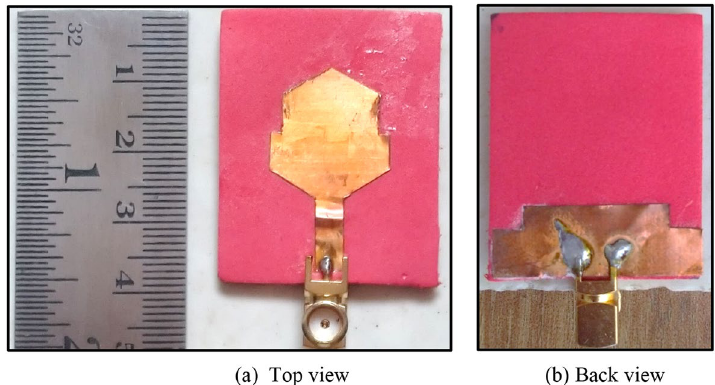
Fig. 4 Photographs of fabricated flower bud-shaped hexagonal microstrip antenna (FBHMSA). The fabricated prototype of a flower bud-shaped hexagonal microstrip antenna (FBHMSA) is made and presented in this figure. The cut at the top of the hexagon with the scale measurement represents a patch, i.e., top view of the fabricated prototype as shown in a , whereas b represents the back view as the partial ground